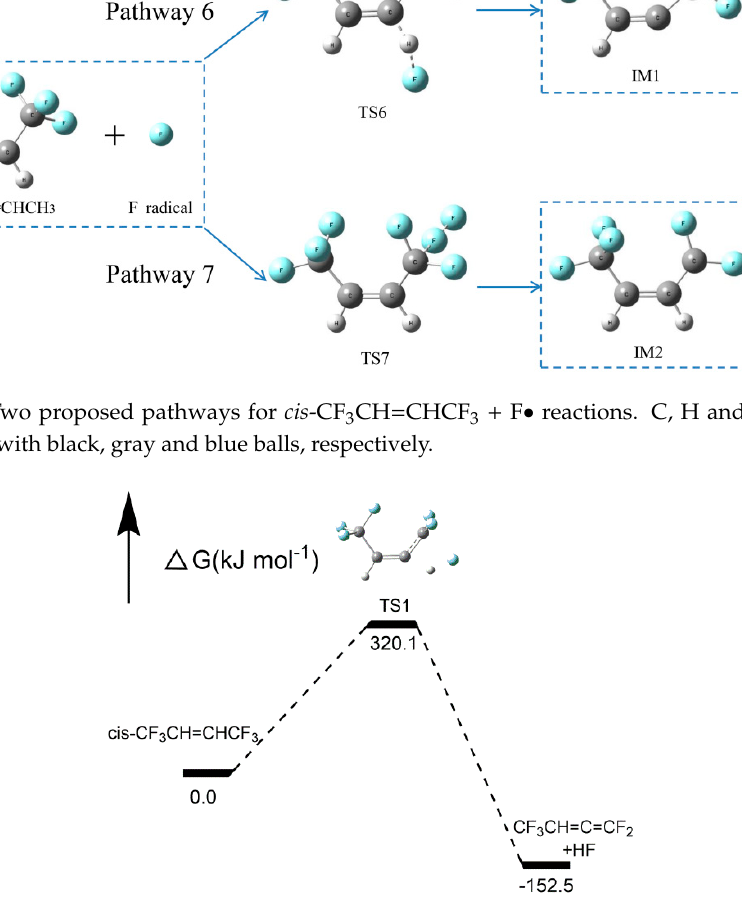
Figure 18. Energy profiles for reaction pathways of cis -CF 3 CH = CHCF 3 + F • . C, H and F atoms are represented with black, gray and blue balls, respectively.